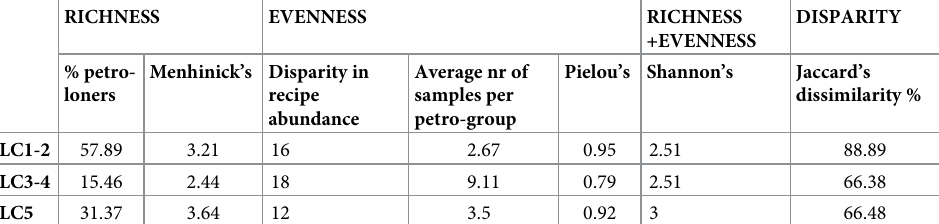
Table 10. Values of the diversity parameters considered for each LC